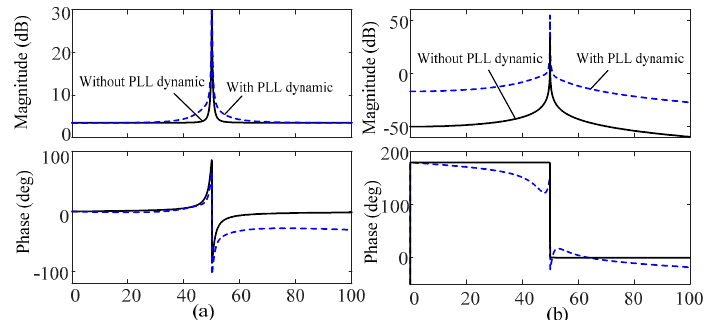
Figure 7. The frequency curves of the elements in the transfer matrix G ctrl ( s ) with or without PLL dynamics: ( a ) the frequency curves of a diagonal element; and ( b ) the frequency curves of off-diagonal elements.